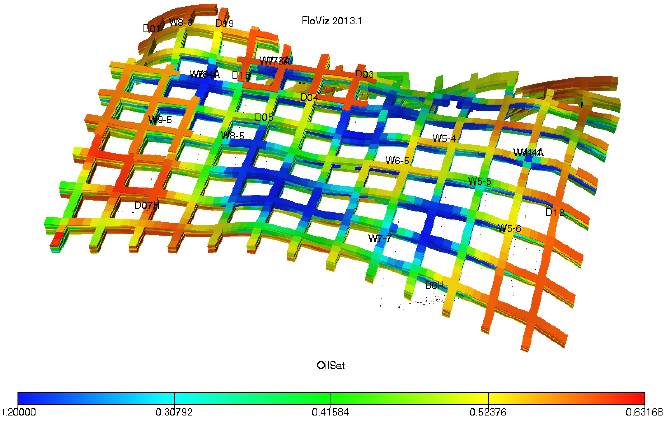
Figure 12. The water and polymer flooding status in the later stage of the water / polymer flooding of the oil group I.